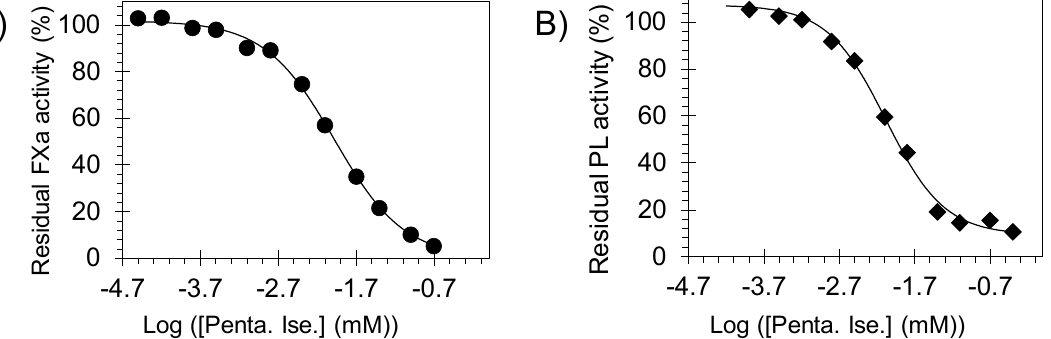
Figure 4. Direct inhibition of human FXa ( ● , A) and human plasmin ( ♦ , B) by pentamidine isethionate (0–400 μ M). Solid lines represent sigmoidal dose − response fit (Equation 1) for the data to obtain the values of IC 50 , HS, and Δ Y (%). Table 2. The inhibition profile of pentamidine isethionate towards several enzymes of relevance to coagulation, inflammation, and digestion. a)